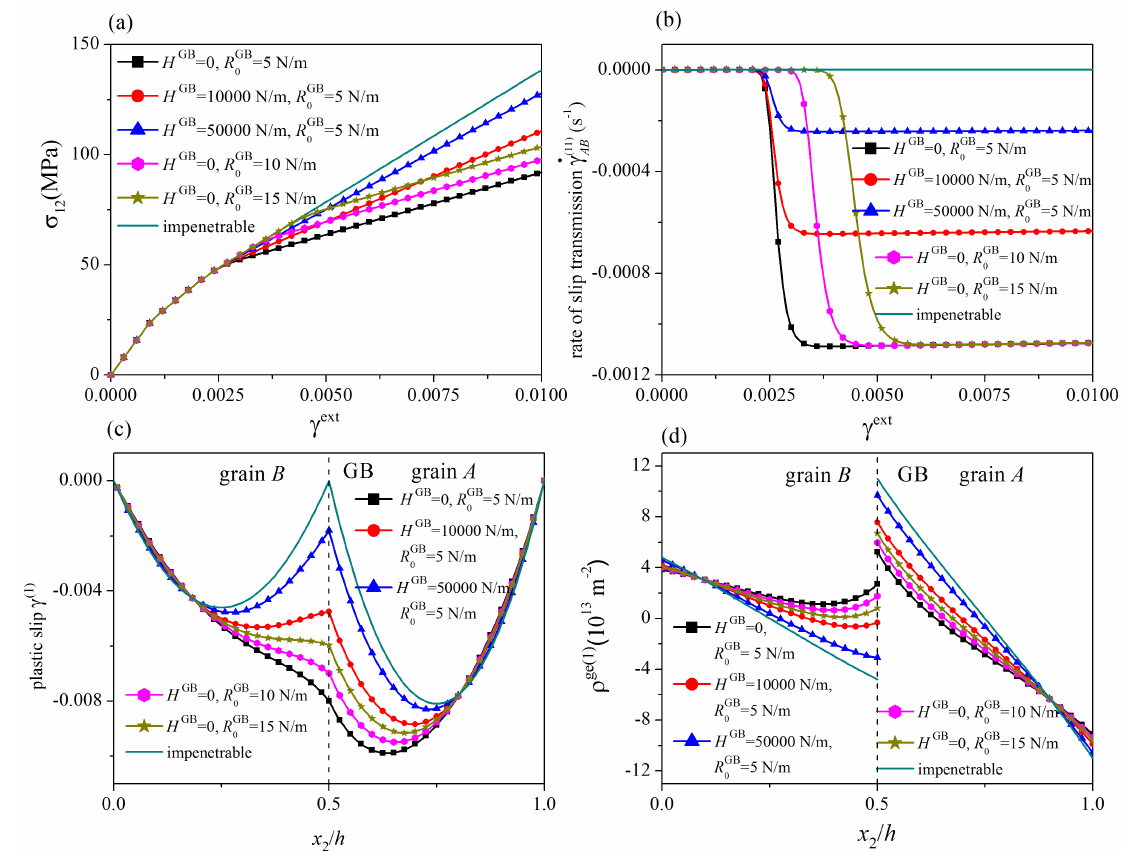
Figure 4. Influence of dissipative GB parameters: ( a ) stress-strain curves; ( b ) the rate of slip transmission; ( c ) distribution of plastic slip at γ ext = 0.01; ( d ) distribution of GND density at γ ext = 0.01. For decreasing dissipative GB hardening modulus H GB , the steady-state value of the rate of slip transmission increases, the strain hardening rate after the onset of slip transmission decreases, and the curve of distribution of plastic slip becomes smoother at the